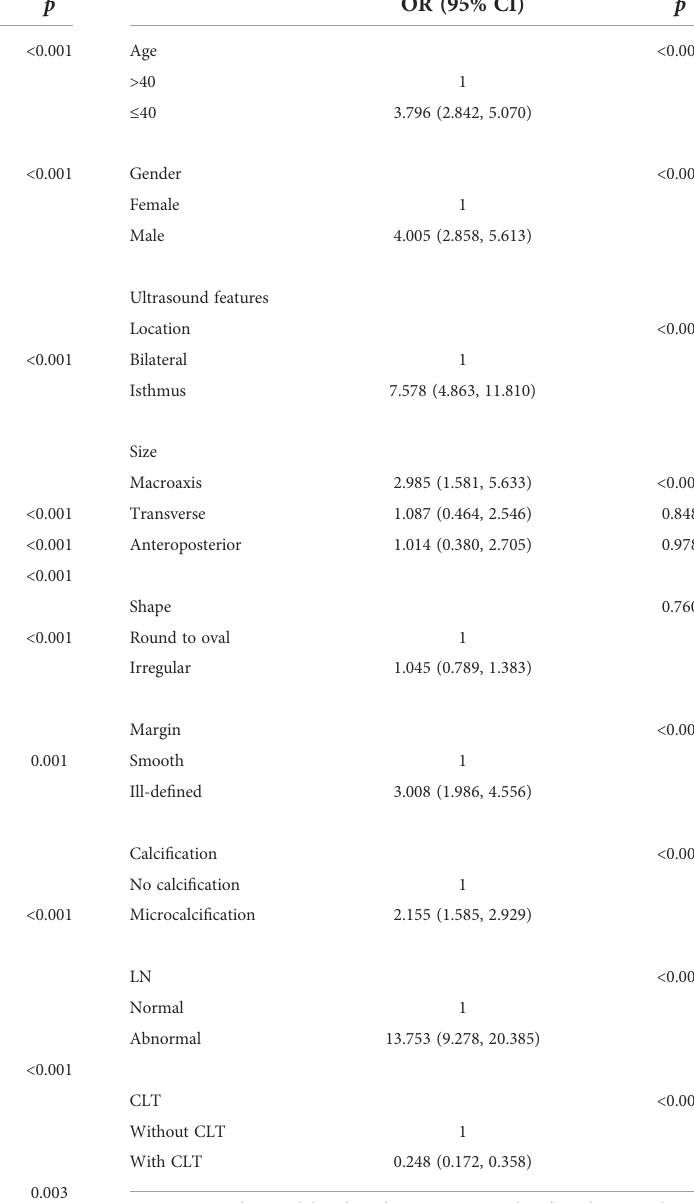
TABLE 2 Univariate analysis for large-volume CCLNM. TABLE 3 Multivariate analysis for large-volume